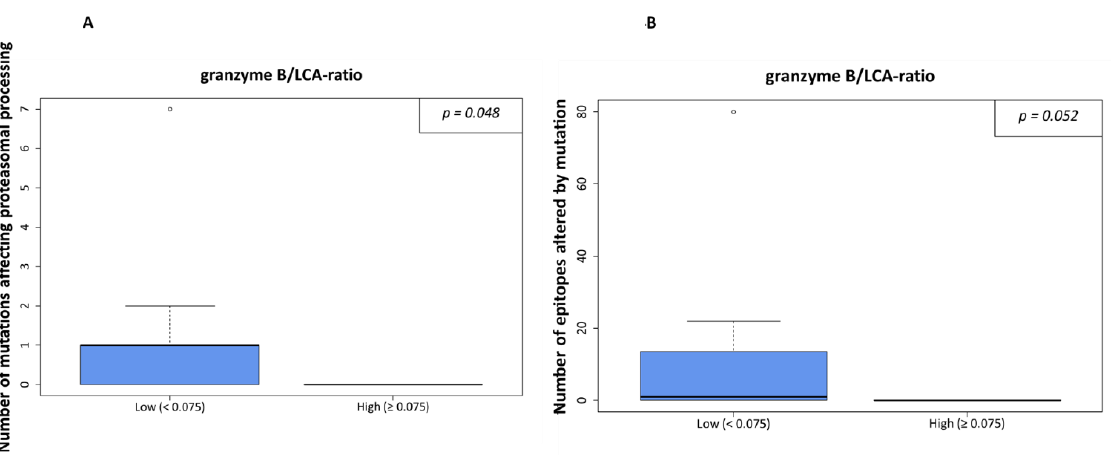
Figure 4. Processing escapes and proportion of granzyme B-positive cells from all leucocytes (LCA- positive). In ( A ), the ratio is shown in relation to numbers of non-synonymous mutations influencing proteasomal processing. The cutoff was set at 7.5% as density distributions exhibited a bimodal distribution with an optimal threshold value at 0.075. In ( B ), the same calculation is shown for the number of epitopes altered by mutation.